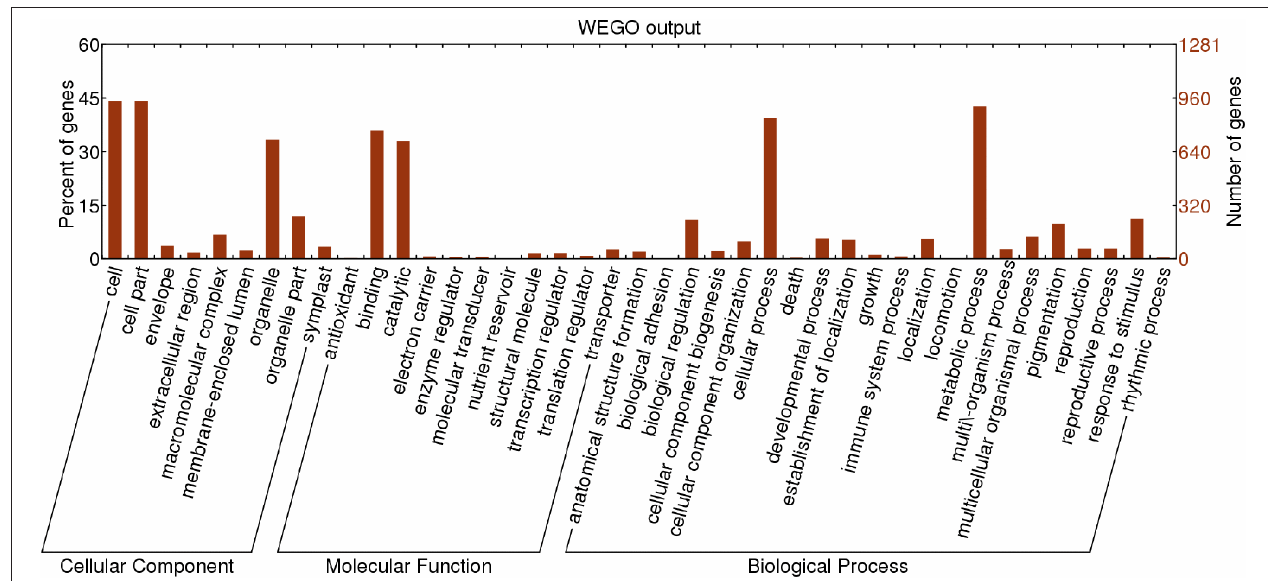
FIGURE 8 | Functional classification of targets of known miRNAs according to Gene Ontology (GO) categories. Enriched GO data were plotted using WEGO (http://wego.genomics.org.cn/cgi-bin/wego/index.pl). The left Y-axis represents the percentages of targets of known miRNAs in each main category. The right Y-axis indicates the numbers of targets of known miRNAs in each GO